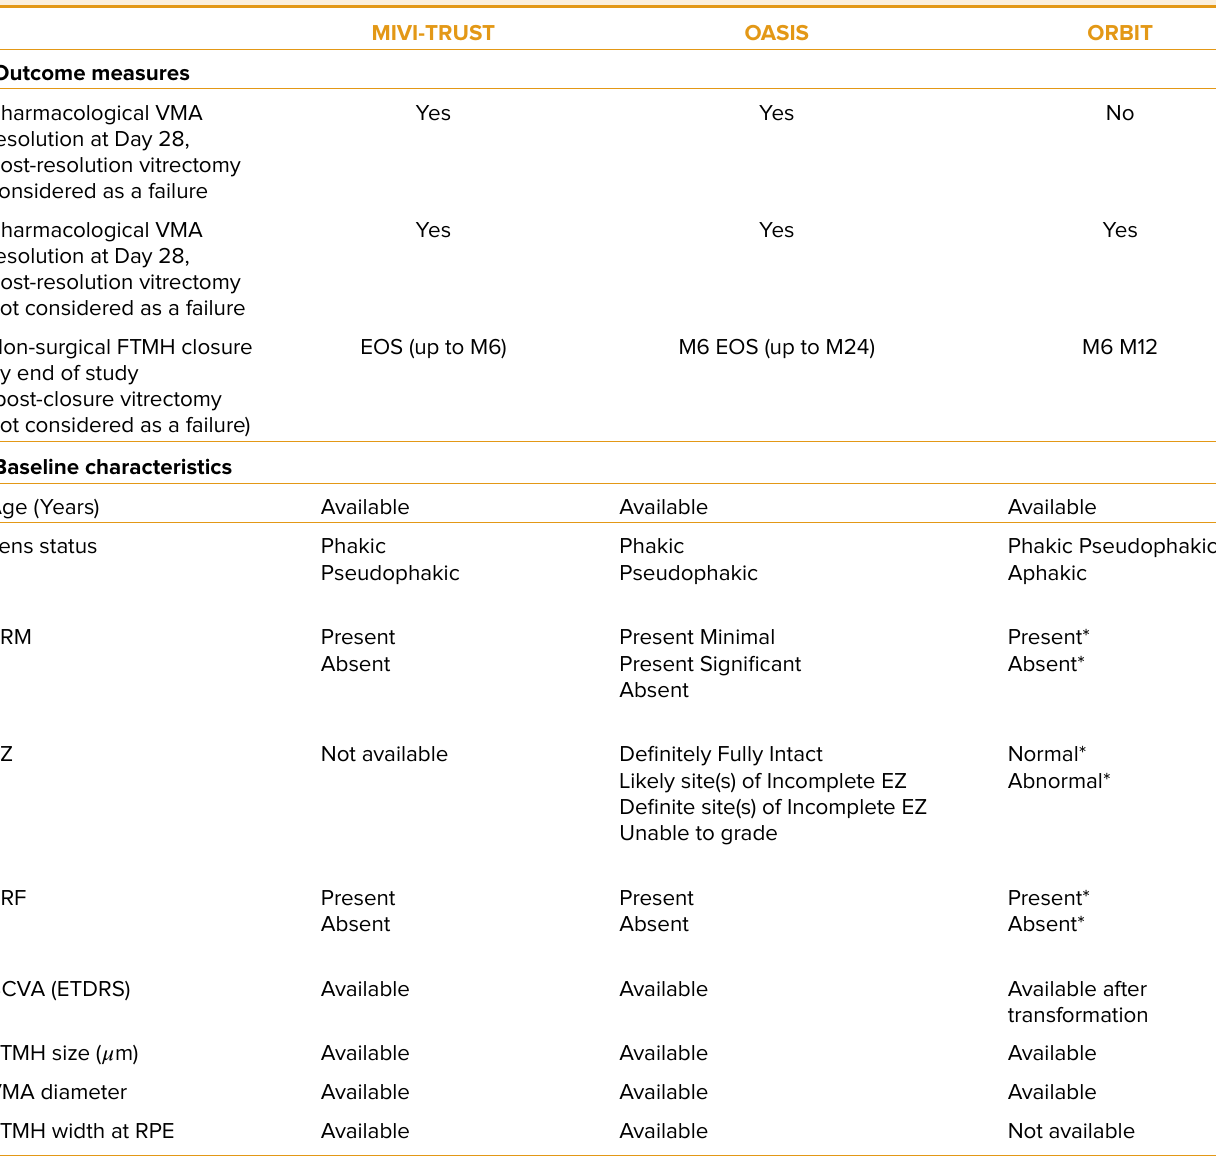
Supplemental Table 1. Availability of baseline characteristics and outcome measures in the ocriplasmin